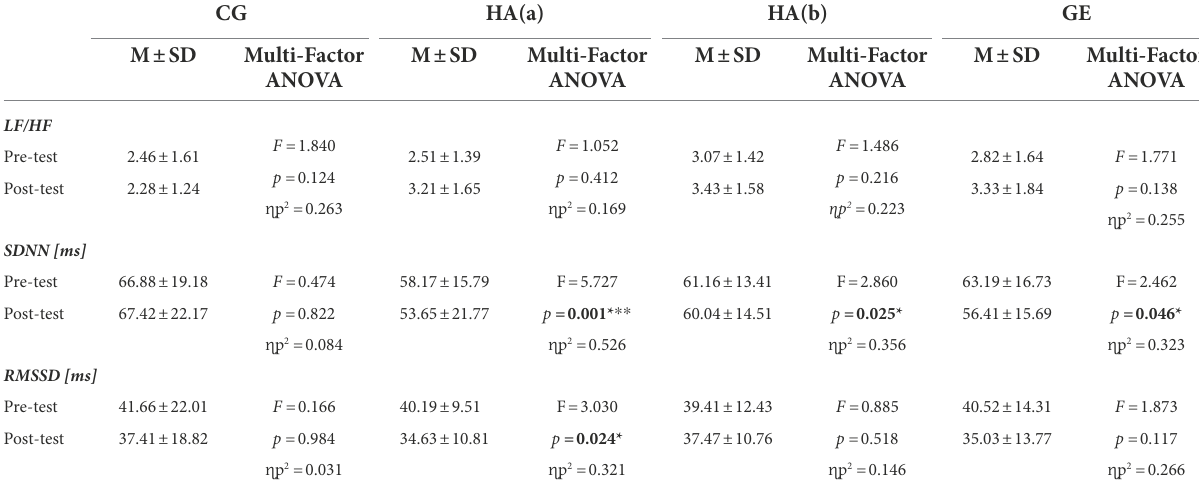
TABLE 3 The difference in test results of the heart rate variability.